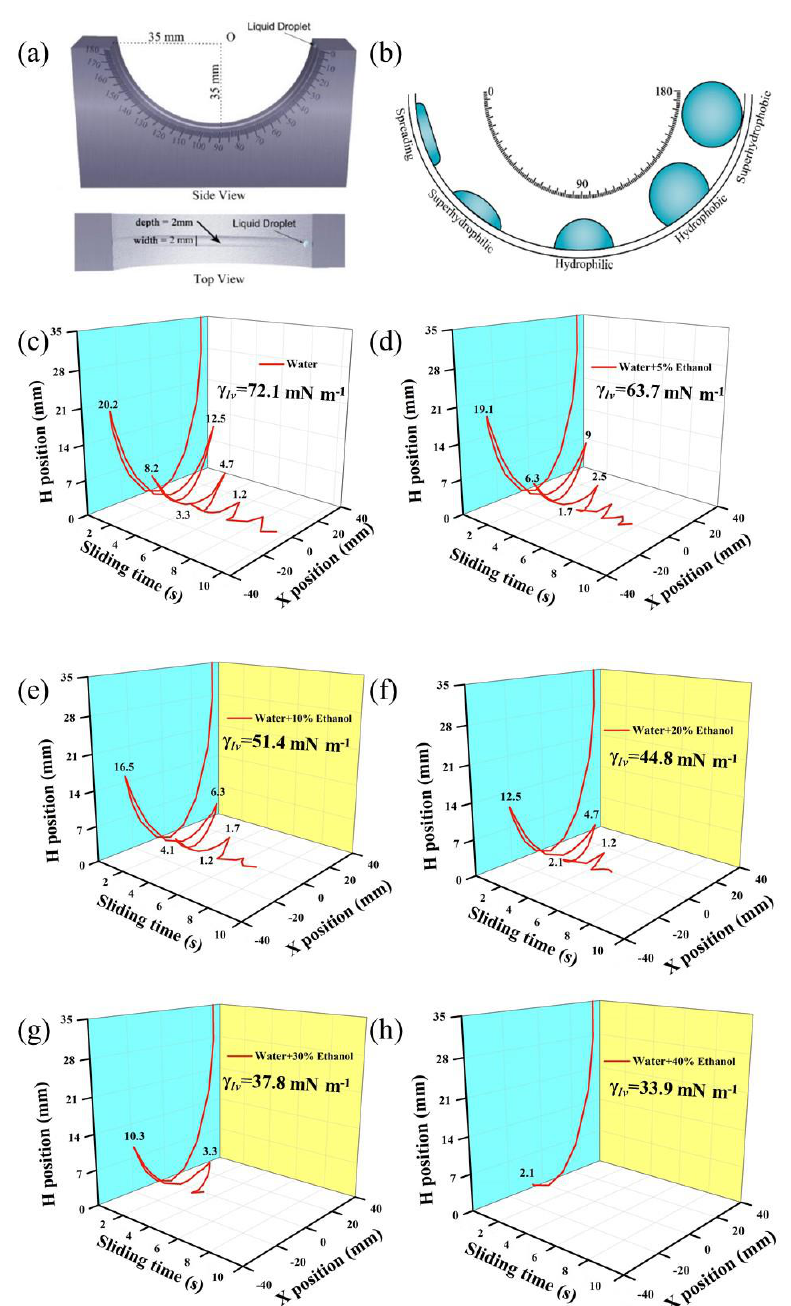
Figure 3. ( a ) Side and top views of our device for droplet sorting, surface tension estimation, and AS prediction. ( b ) Images of droplets with various surface tensions in the guide groove. ( c – h ) Schematics showing the fine sorting of droplets by surface tension using our device and measuring their rolling time or distance. By recording the entire motion of a droplet along the guide groove in slow motion with a smartphone, we calculated its total rolling time and distance. In calculating the total distance, by marking the highest position each time the droplet moved back and forth in the groove, the total